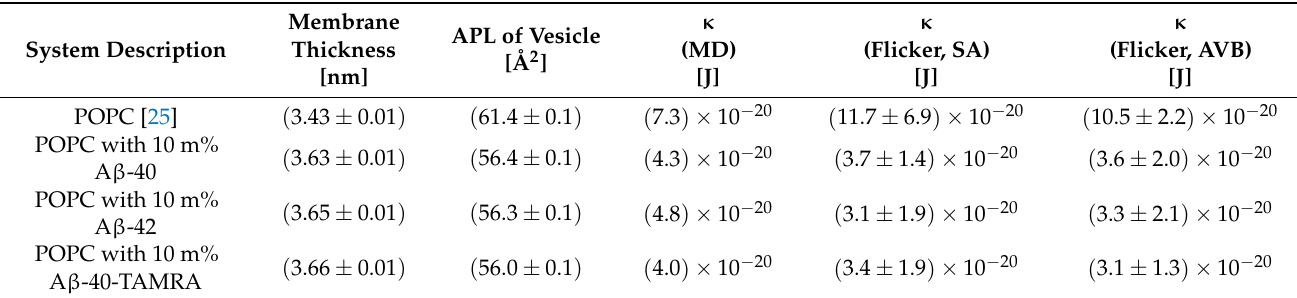
Table 1. Summary of Calculated Parameters from a Molecular Dynamics (MD) Study and Flicker Noise Spectroscopy Measurements for POPC membrane with incorporated A β (amyloid- β ) monomers.